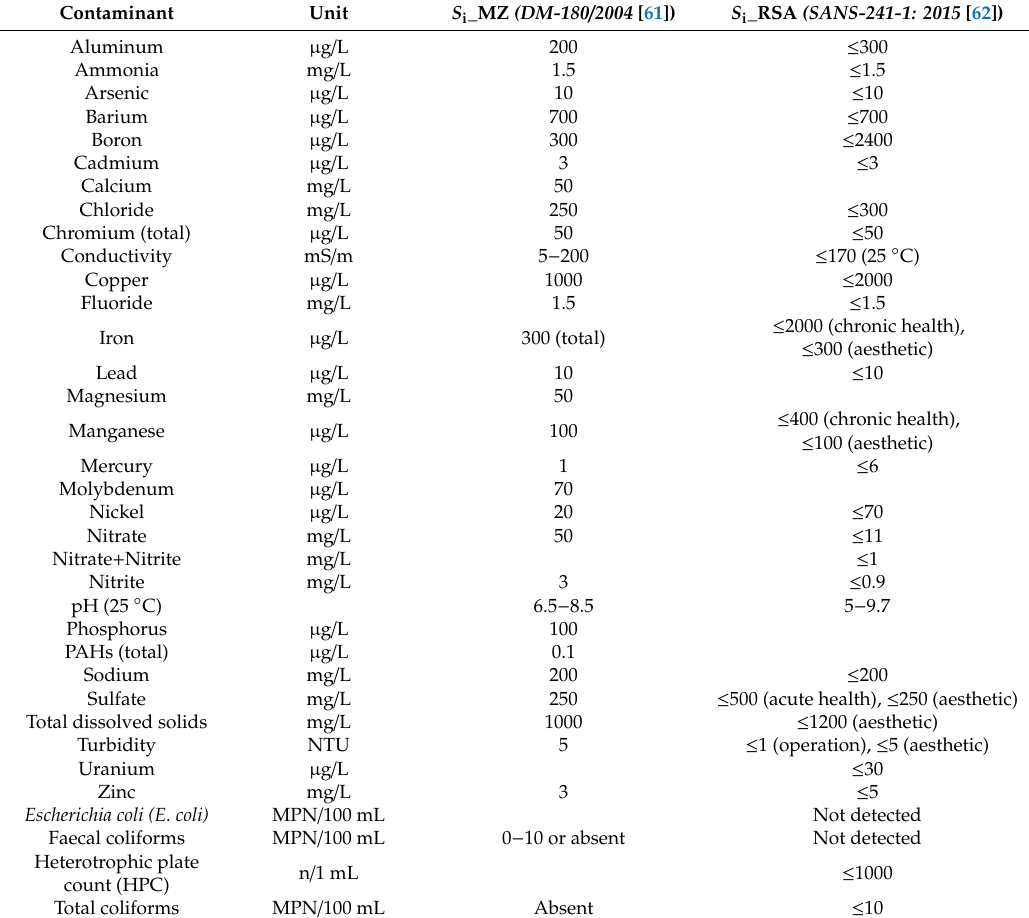
Table 2. Drinking water quality standards established in Mozambique ( S i _MZ ) and South Africa ( S i _RSA ).